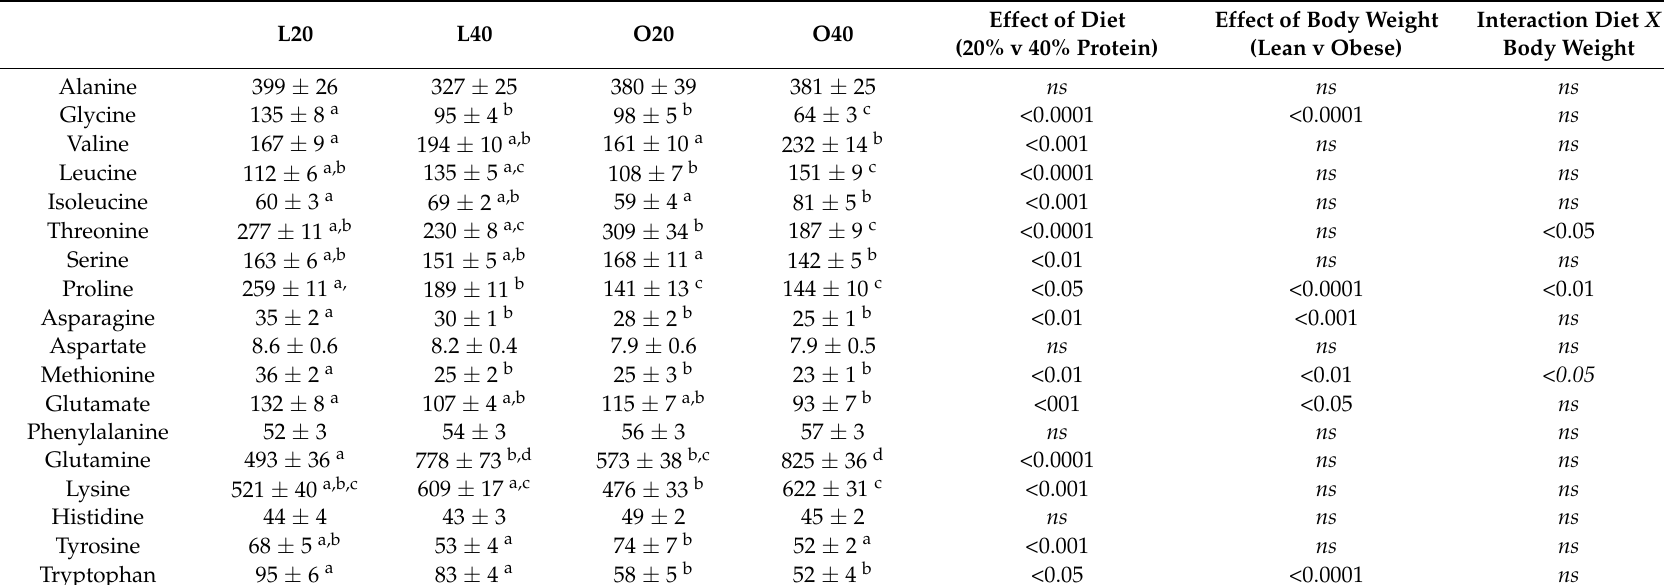
Table 1. Fasting plasma amino acid composition 1